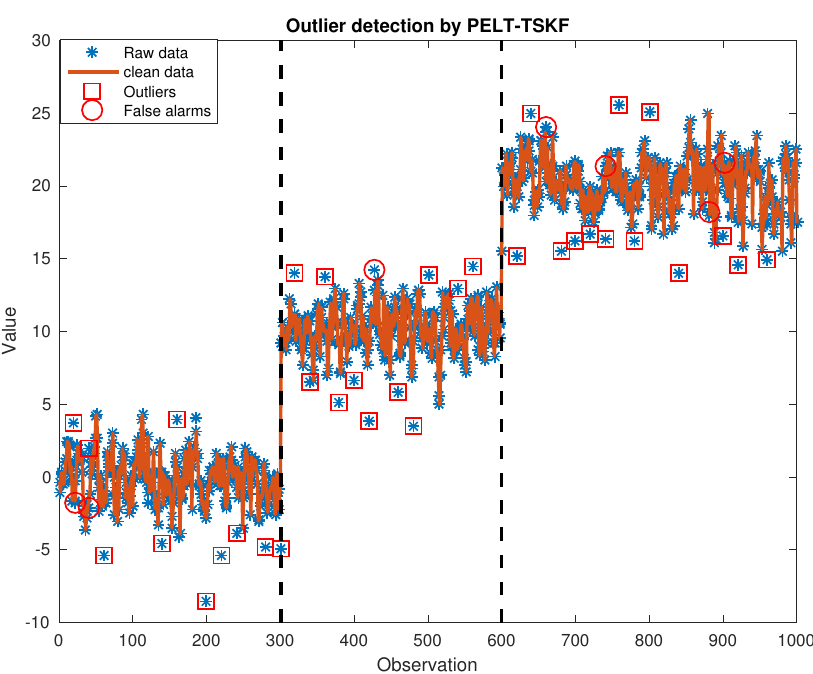
Figure 3. Outlier detection by pruned exact linear time—time series Kalman filter (PELT-TSKF).